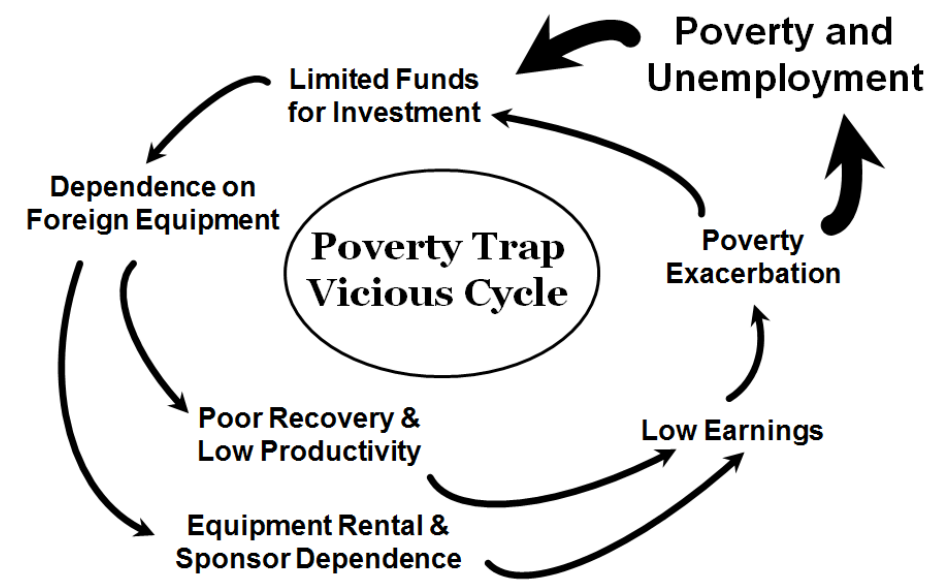
Figure 3. Illustration, modified from Hilson [35] after UNECA [41], of the “Poverty